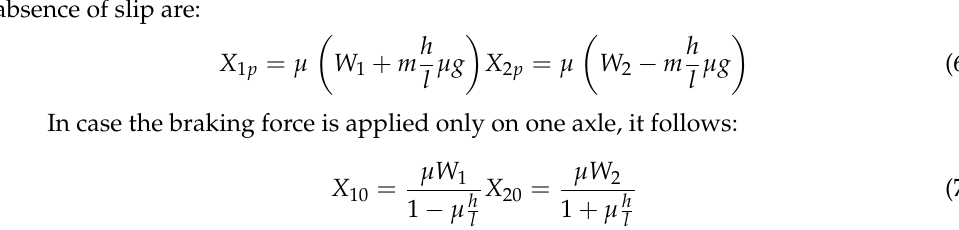
The braking region is presented in Figure 6. Blue lines and purple lines respectively represent the grip limits with dry and wet road. Red lines represent the mechanical braking forces on the front and the rear wheels. Dotted black lines represent the points where the sum of the rear and front braking forces is constant, and also at constant car deceleration (within the region where there is no grip loss). The blue dotted area indicates the